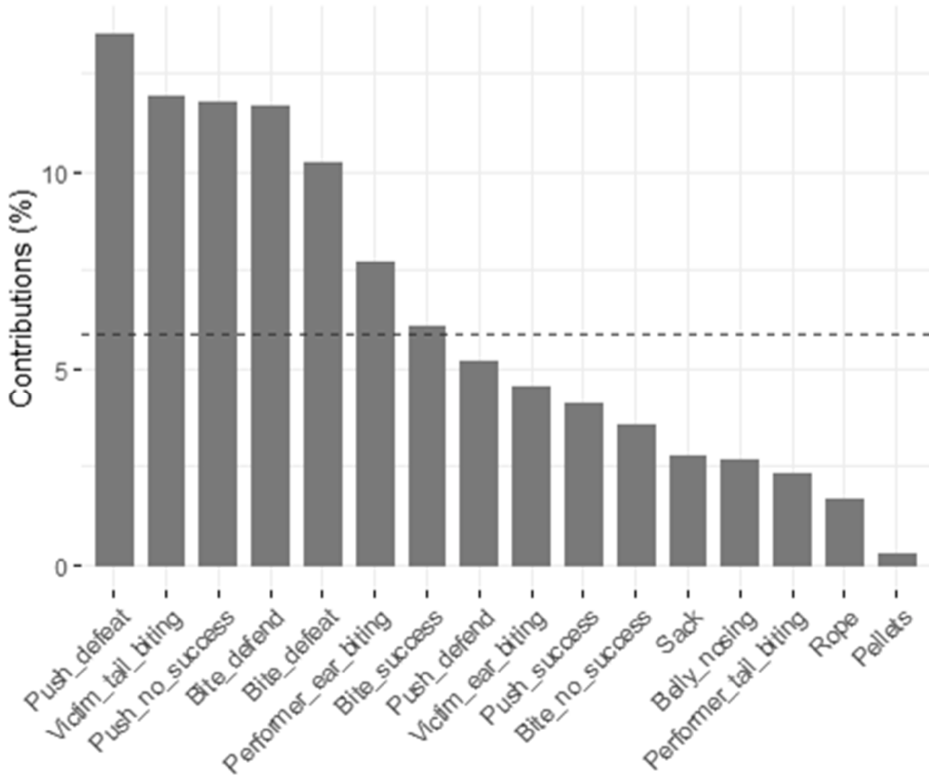
Figure 5. Contribution of variables to principal component factors 1 and 2 for cluster 1; dashed line = expected value if contribution were uniform.